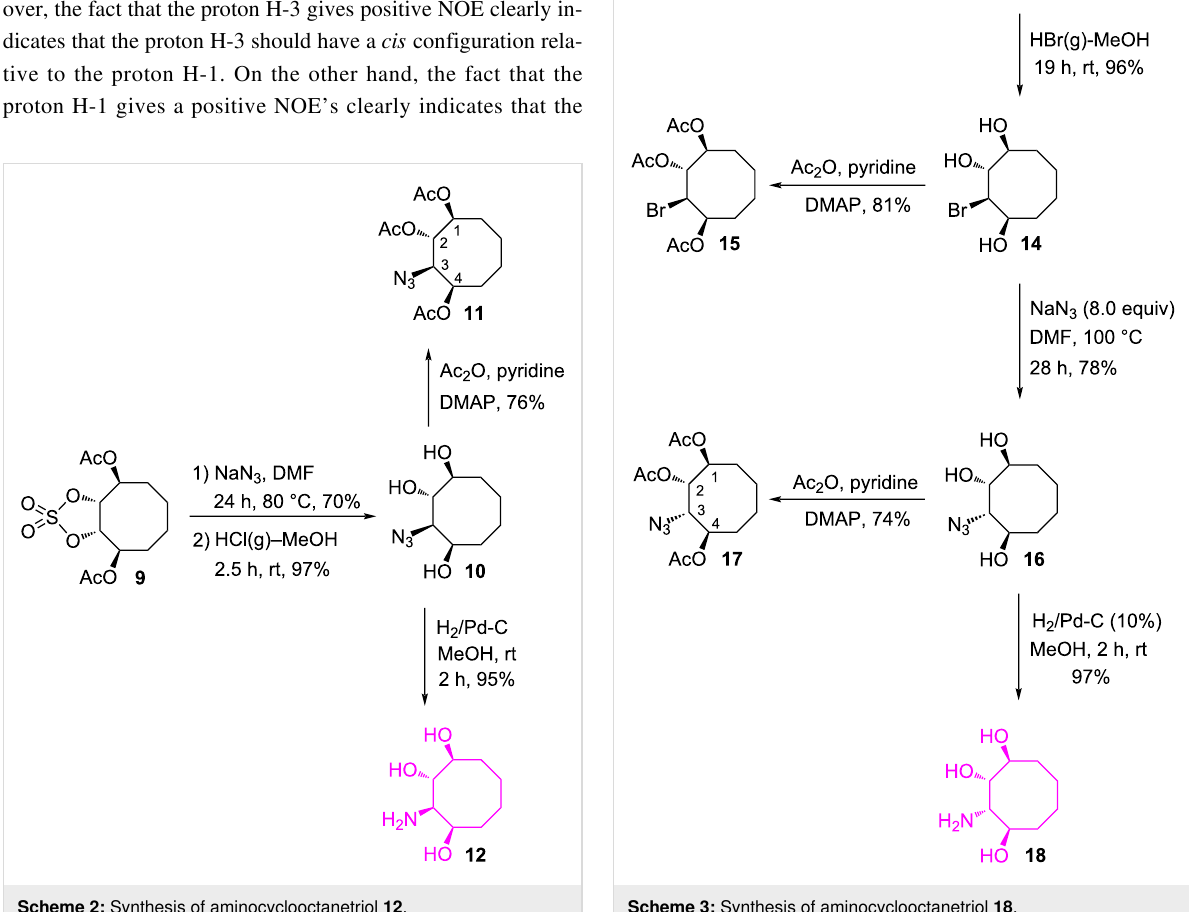
Scheme 2: Synthesis of aminocyclooctanetriol 12